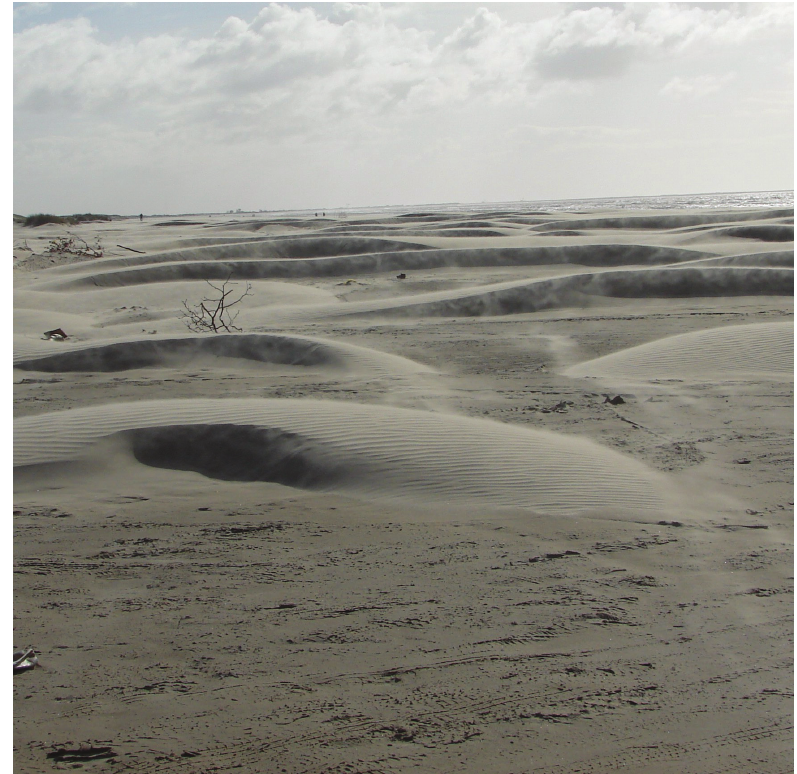
Figure 1 - Image of Cassino Beach showing ephemeral dunes in the